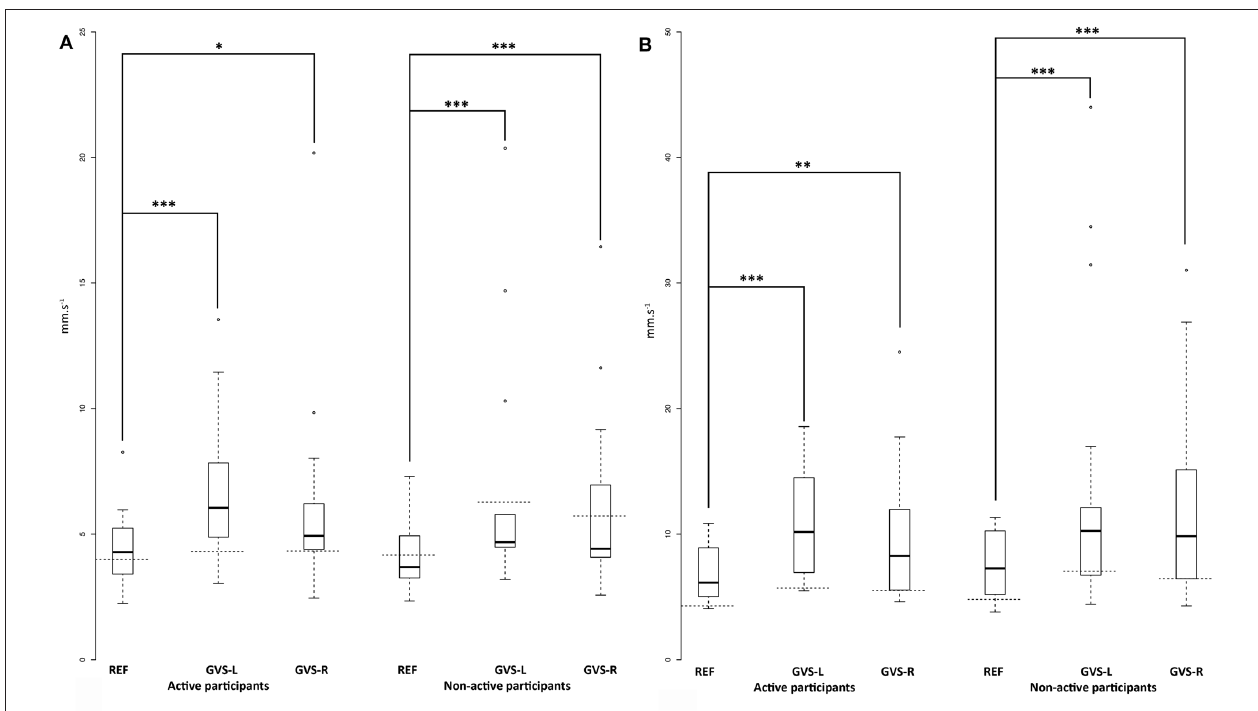
FIGURE 1 | The center of foot pressure (COP) X velocity (A) and the COP Y velocity (B) in the reference and the galvanic vestibular stimulation (GVS) conditions for the active and non-active groups. ∗ Indicates p < 0.05. ∗∗ Indicates p < 0.01. ∗∗∗ Indicates p < 0.001. The horizontal broken lines indicate median values for young participants from Maitre and Paillard (2016).